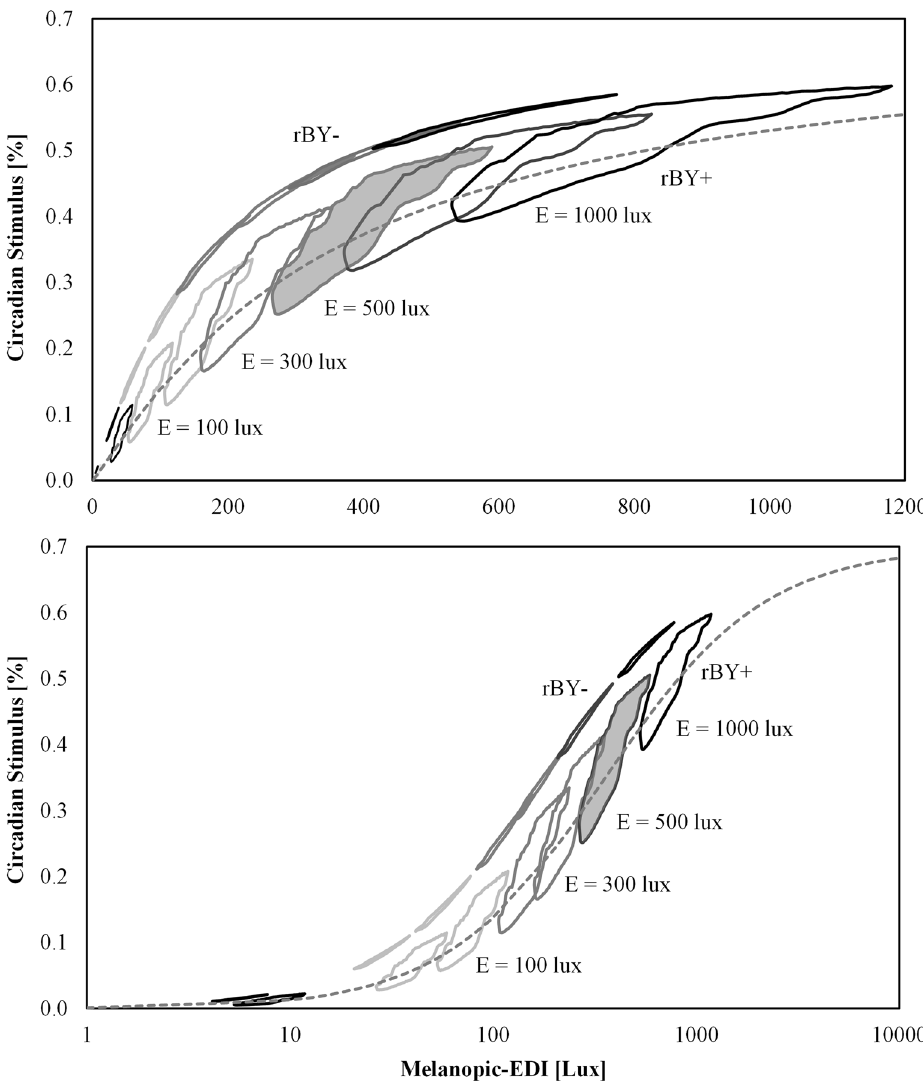
Figure 12. Circadian Stimulus (CS) as a function of melanopic equivalent daylight illuminance (mel-EDI) with sub-divisions for photopic illuminance represented as boundaries of the data. (Top) Linear scaling for the x-axis. (Bottom) Logarithmic scaling for the x-axis. Overall, there is a wide range of achievable CS values at a fixed mel-EDI and a strong discontinuity due to the b-y spectral opponency of the CS model (“yellow wins” indicated by rBY-, and “blue wins” indicated by rBY+). No simple or satisfactory mathematical conversion between CS and mel-EDI can be offered. The grey shaded area indicates the sub-division of the data with an illuminance of 500 lx, which is enlarged in Fig.